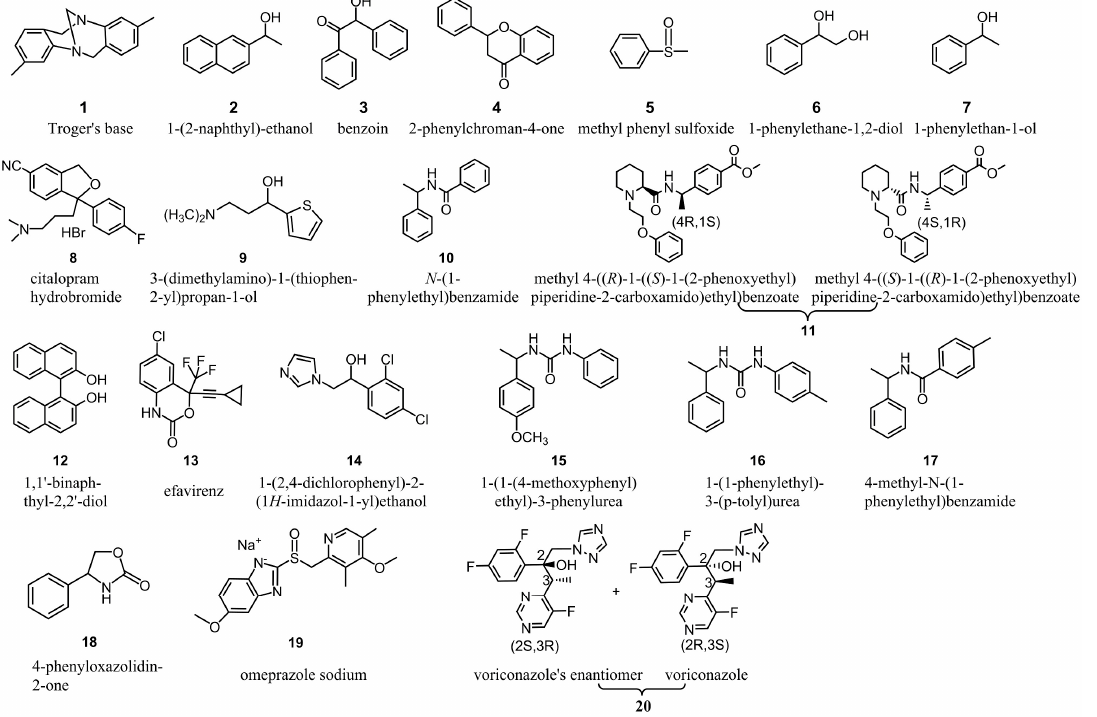
Figure 3. Structures of chiral analytes tested.